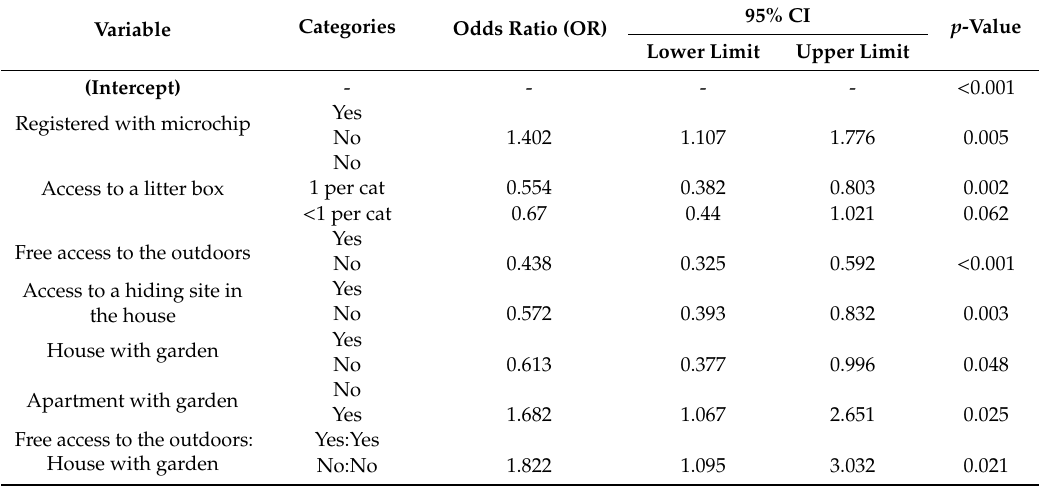
Table 2. Final model results from the multivariate logistic regression analysis. The odds ratio, 95% confidence interval (C.I.), lower and upper limit, and p -value are reported for the variables that were retained in the model and had an association with cats bringing back home